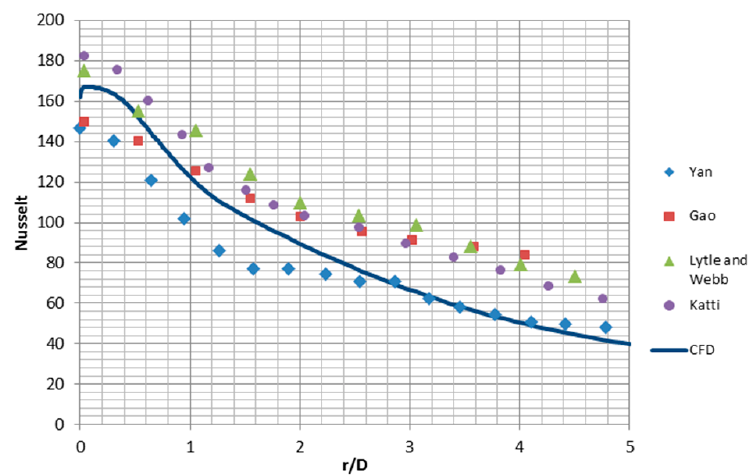
Figure 4. Nusselt number along the wall H/D = 6—CFD vs. experimental data.